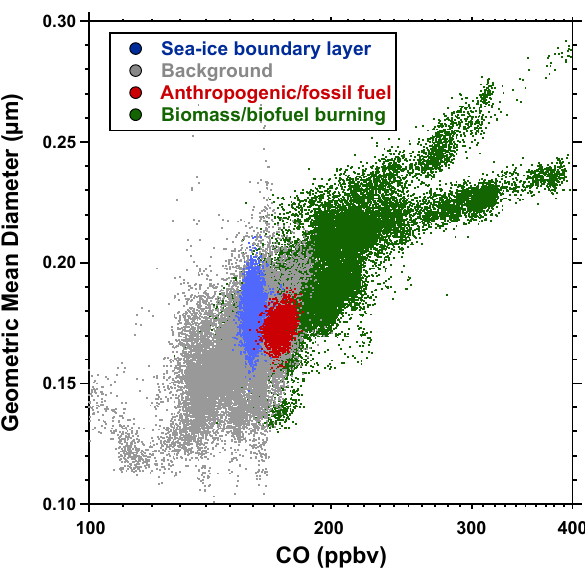
Fig. 8. Number geometric mean diameter as a function of CO mix- ing ratio calculated for particles with diameters from 0.08–1µm in four different airmass